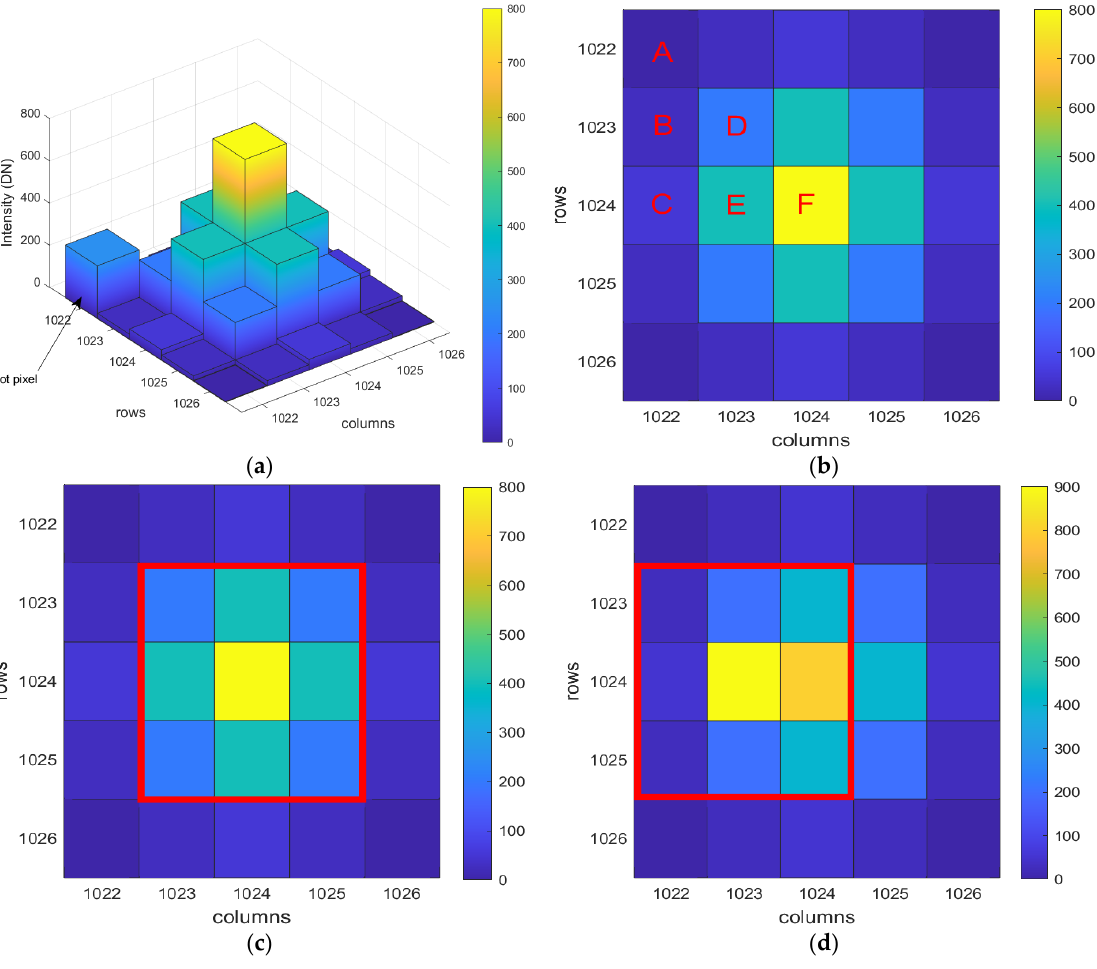
Figure 6. Schematic diagram of star gray value distribution and positioning window: ( a ) star gray value distribution; ( b ) six situations that affect star centroid positioning; ( c ) original centroid positioning window; ( d ) centroid positioning window